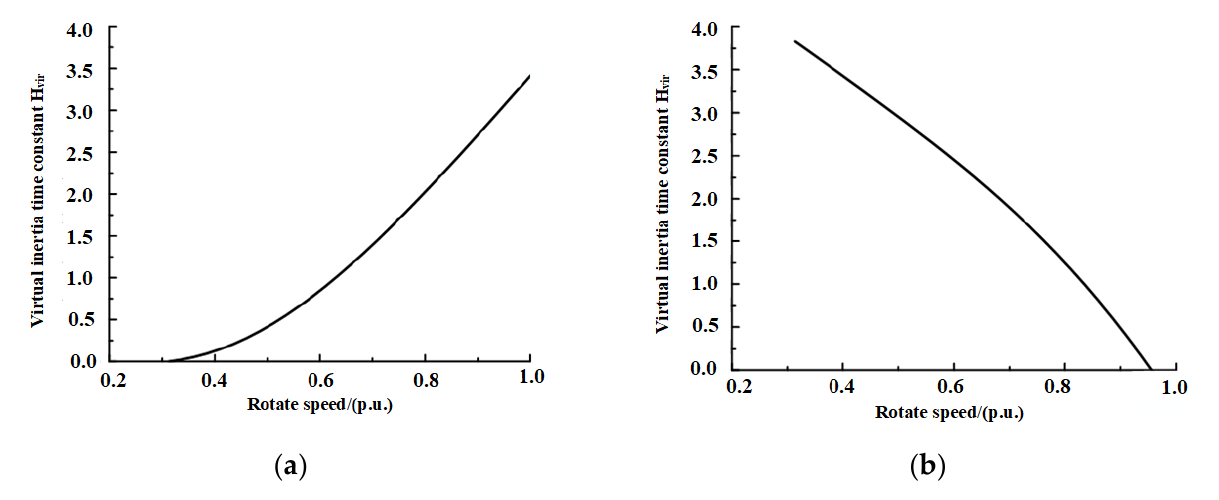
Figure 9. The idea of the wind turbine—energy storage frequency modulation control. ( a ) Curve of the inertia time constant of the wind turbine when the frequency drops. ( b ) Curve of the inertia time constant of the wind turbine when the frequency rises.